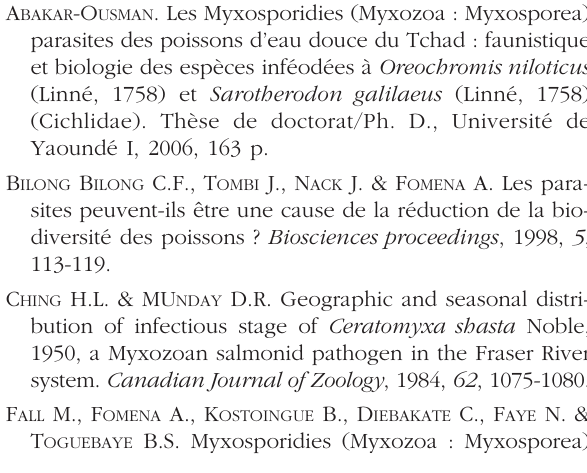
Tableau II. – Mensurations (en mm) des spores des différentes espèces de Thelohanellus connues chez les poissons d’eau douce